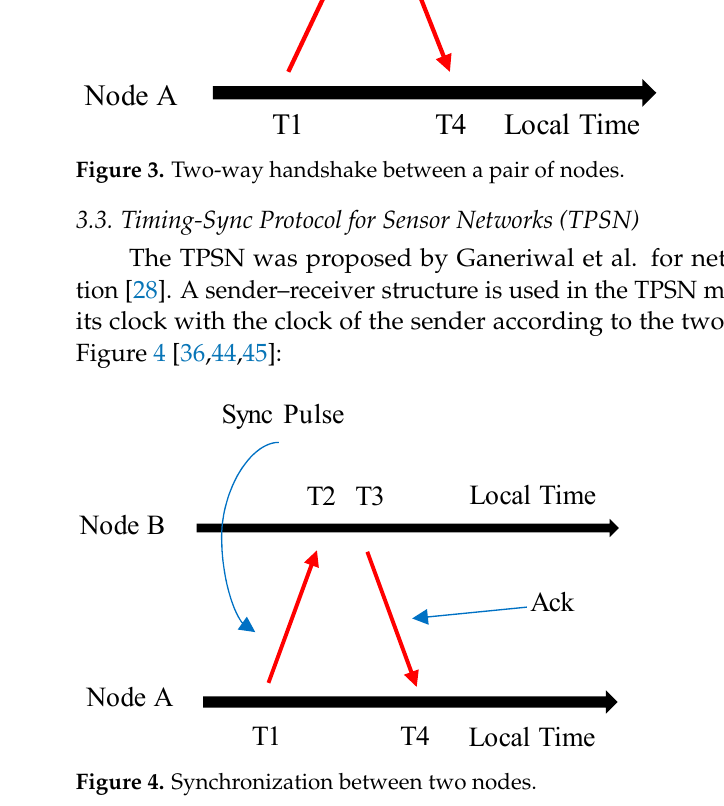
Figure 3. Two-way handshake between a pair of nodes.